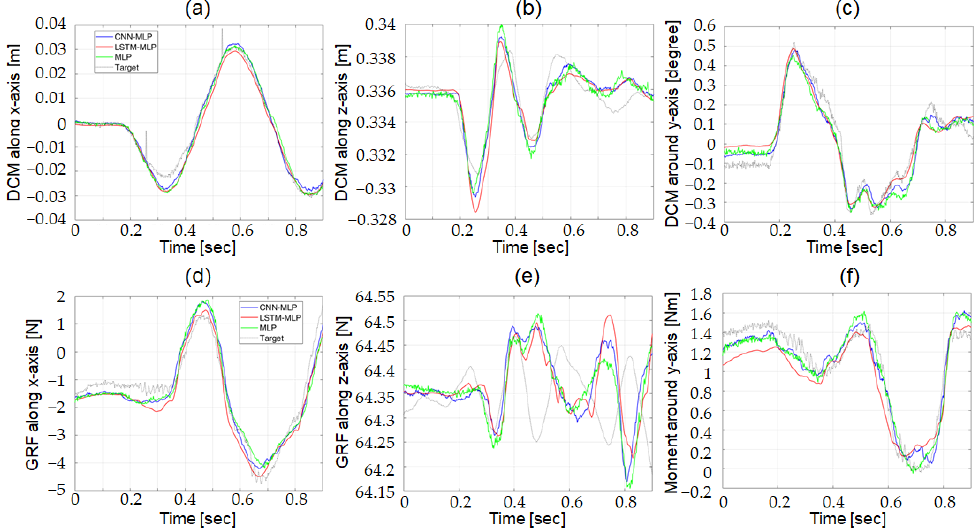
Figure 11. Comparison of target output and predictions from three optimized DNN structures using test data in actual robot; ( a ) DCM along x-axis, ( b ) DCM along z-axis, ( c ) DCM around y-axis, ( d ) GRF along x-axis, ( e ) GRF along z-axis, and ( f ) Moment around